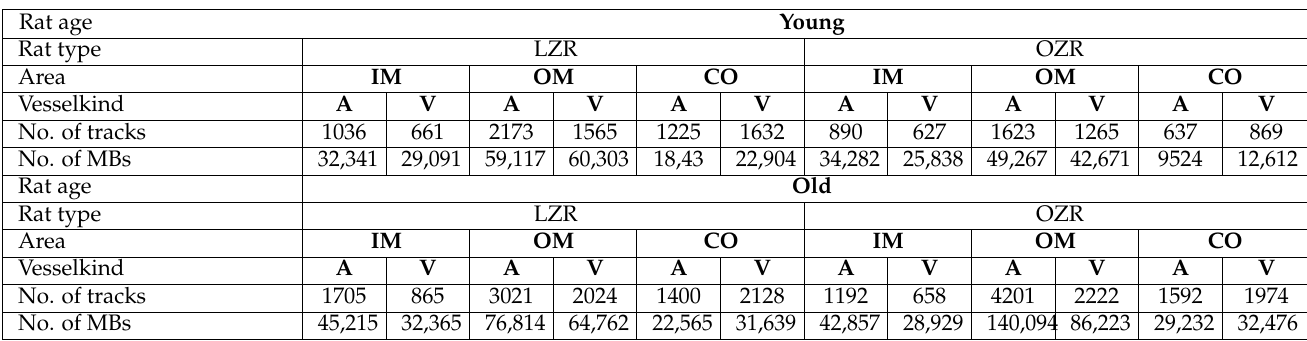
Table 2. Number of tracks and microbubbles (MBs) after filtering in the three different areas separated into arteries (A) and veins (V) in the kidney of obese Zucker rats (OZRs) and lean Zucker rats (LZRs), 11- and 20-weeks-old, respectively.